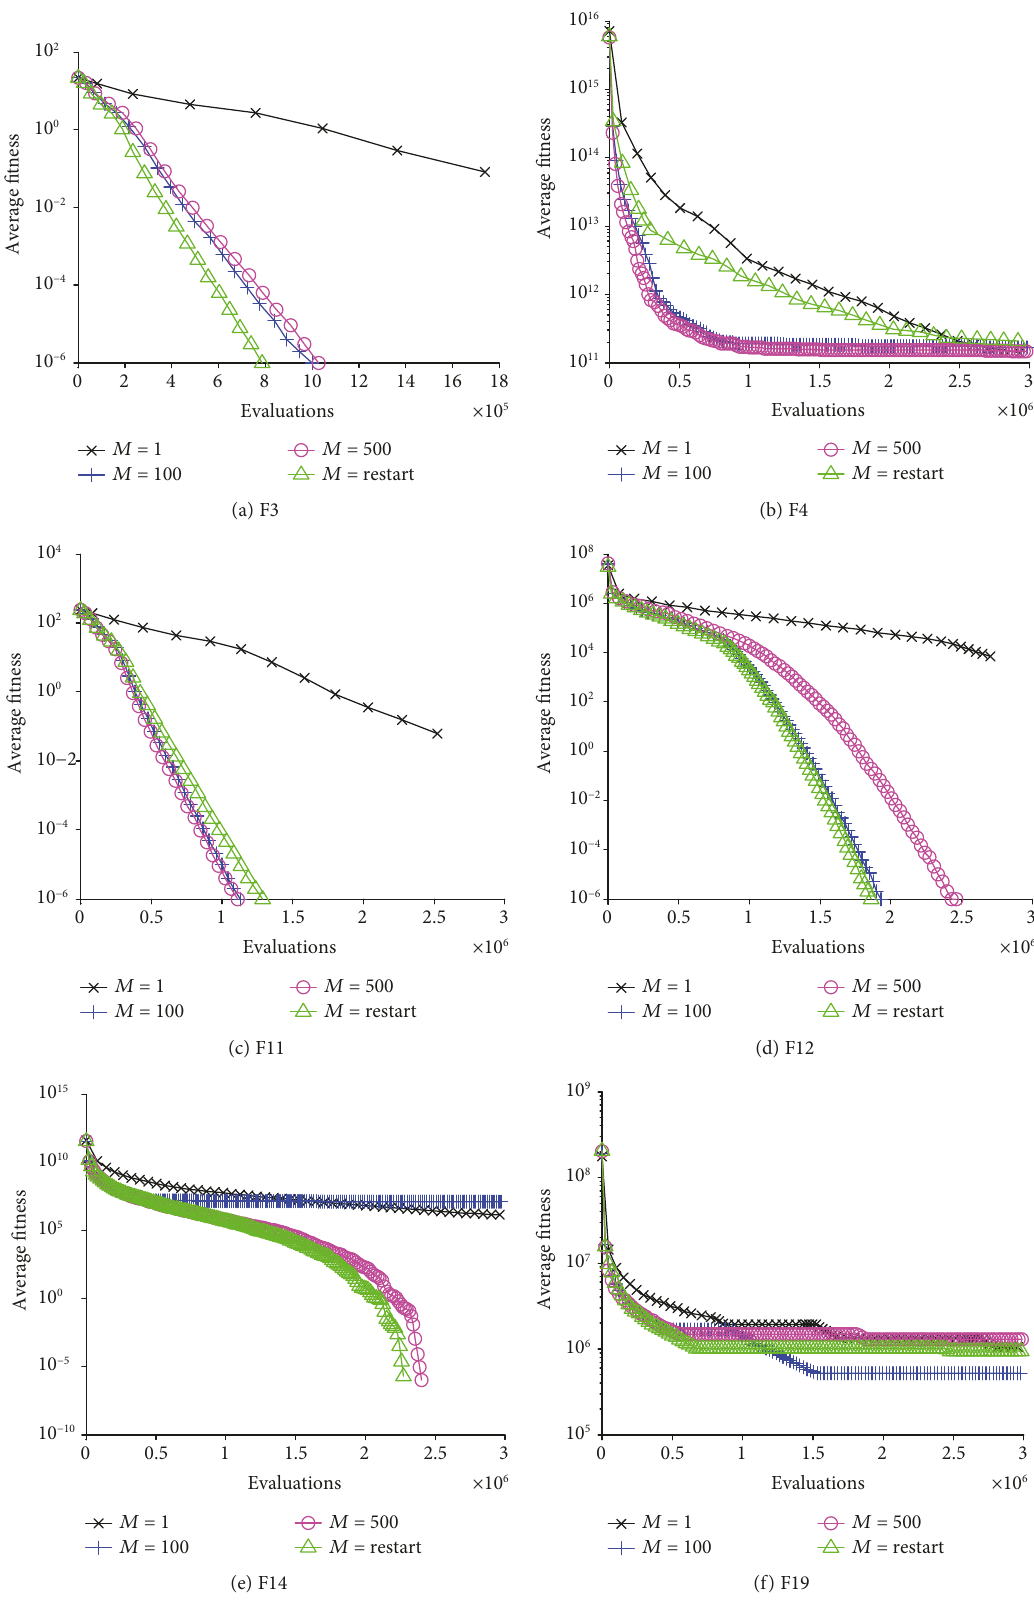
Figure 8: Convergence curves of the CC-SMP with a di ff erent collaboration